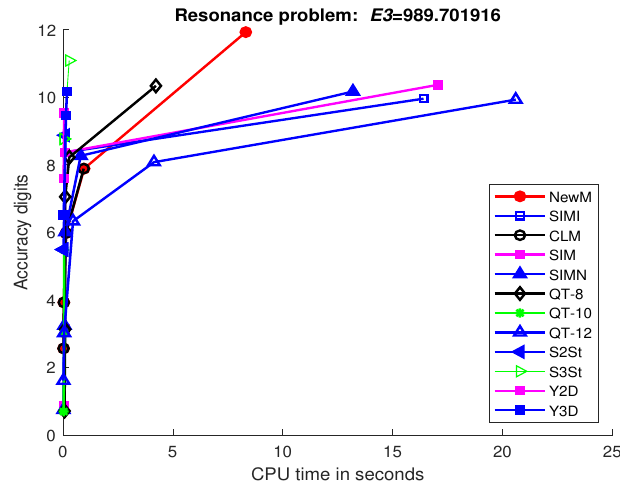
Figure 7. Efficiency of the compared methods for E 3 =